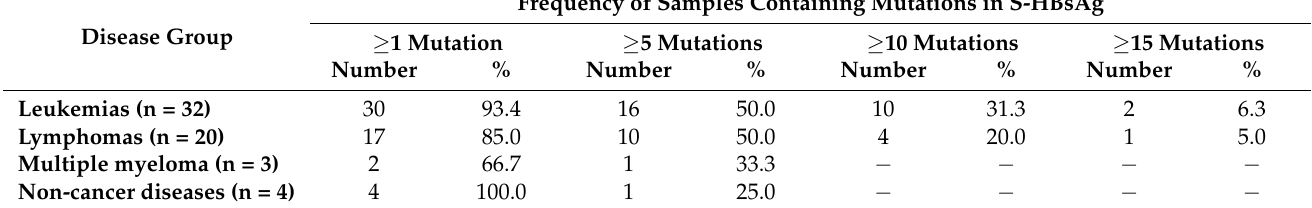
Table 2. Distribution of the total number of S-HBsAg mutations in the same HBV isolate in different groups of patients with hematologic diseases (n = 59).